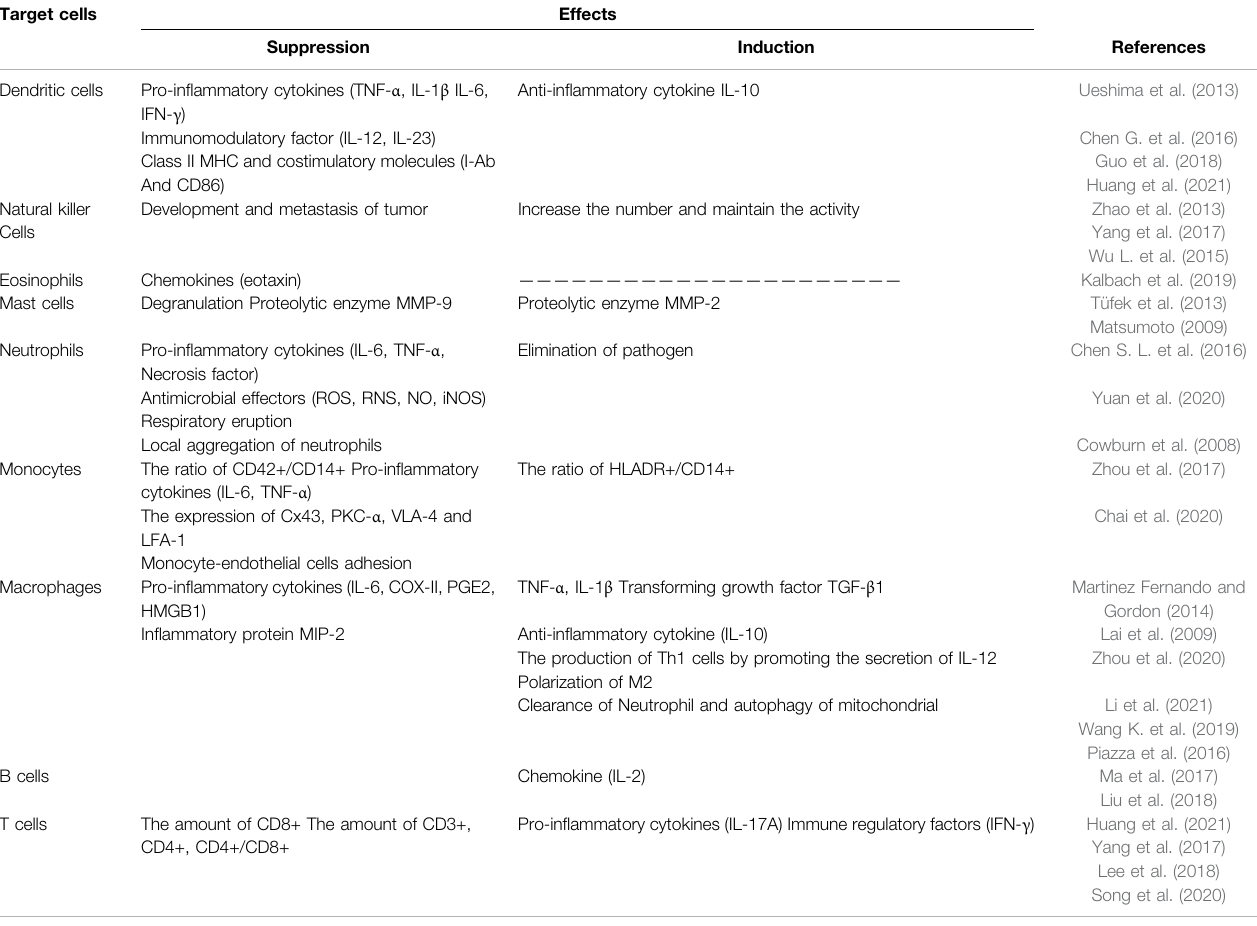
TABLE 1 | Summary table on effects of DEX on immune cells and in fl ammatory cytokines. Target